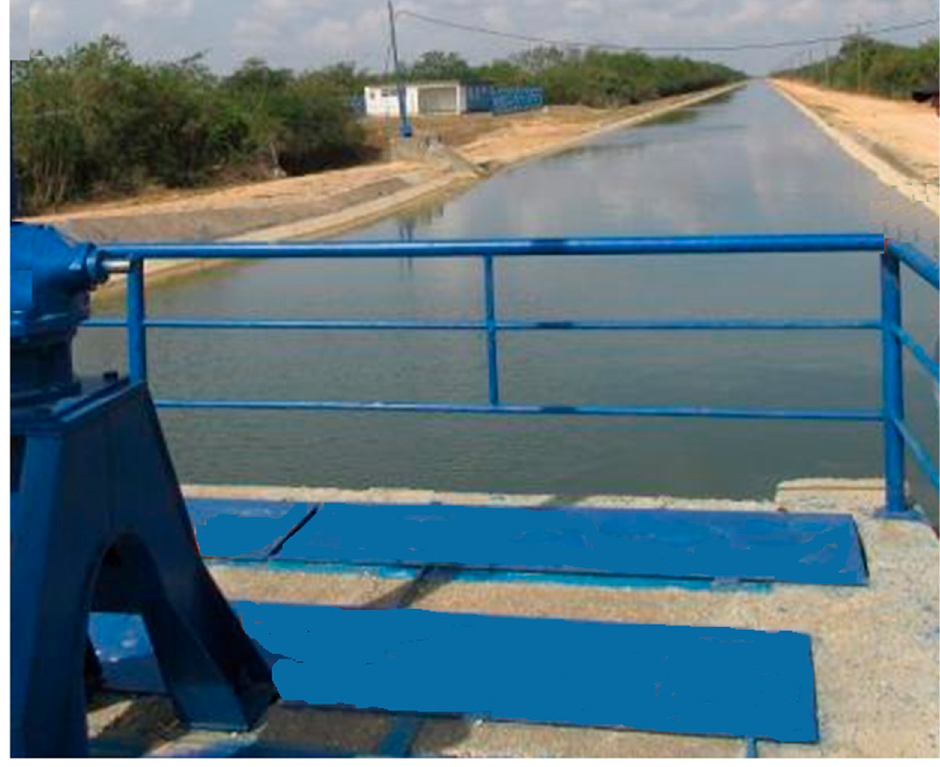
Figure 1. A view of Zaza-Ciego de Avila Main Canal